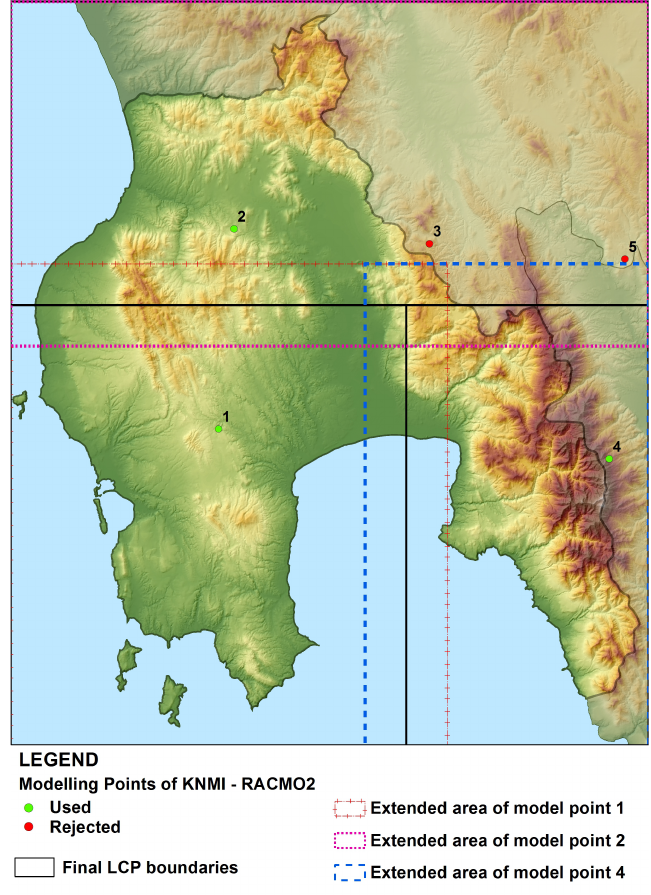
Figure 2. The five prediction points of KNMI RCM RACMO2 model and influence areas of the three used Points 1, 2 and 4 (green) over Messinia,